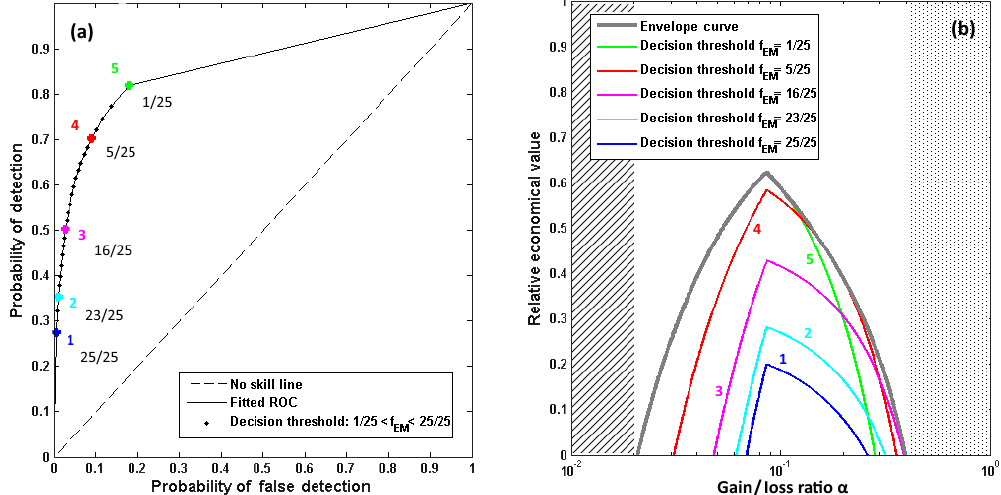
Figure 6. ROC and REV diagram for flow domain forecast based on catchment weighted areal overlap.